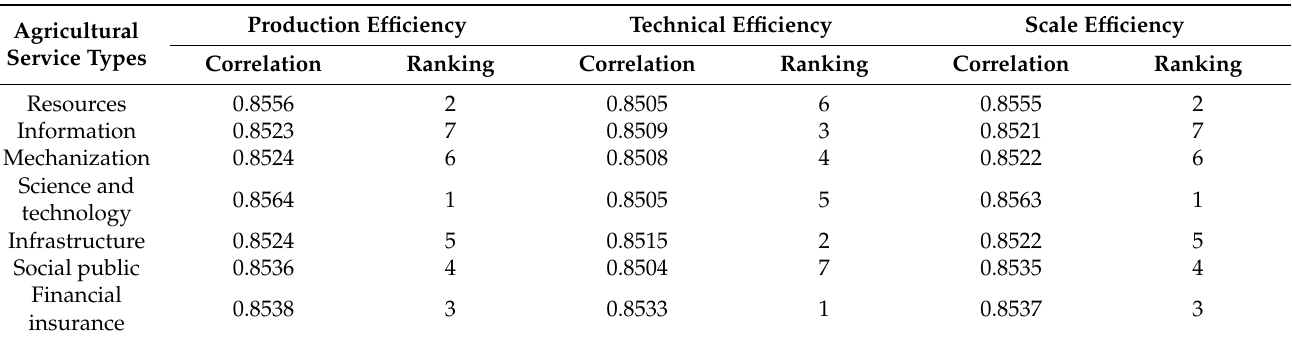
Table 4. Grey correlation between socialized agricultural services and agricultural production